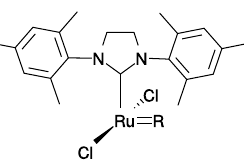
Figure 3. Active species formed from G-II, HG-II, M71-SIMes and M73-SIMes pre-catalysts. R stands for A or B fragments.